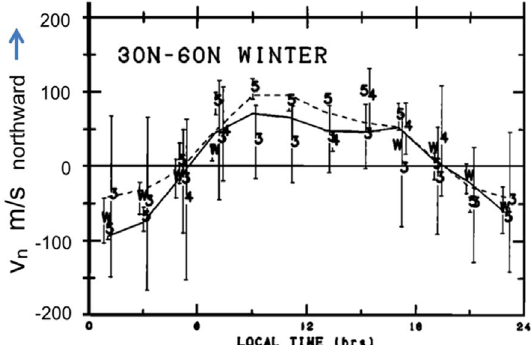
Fig. 17. Thermospheric winds at mid-latitudes in winter (taken from Hedin et al., 1991). The solid and dashed lines correspond to wind models HWM90 and HWM87, respectively. The different numbers refer to different observation techniques. For further details see Hedin et al. (1991).